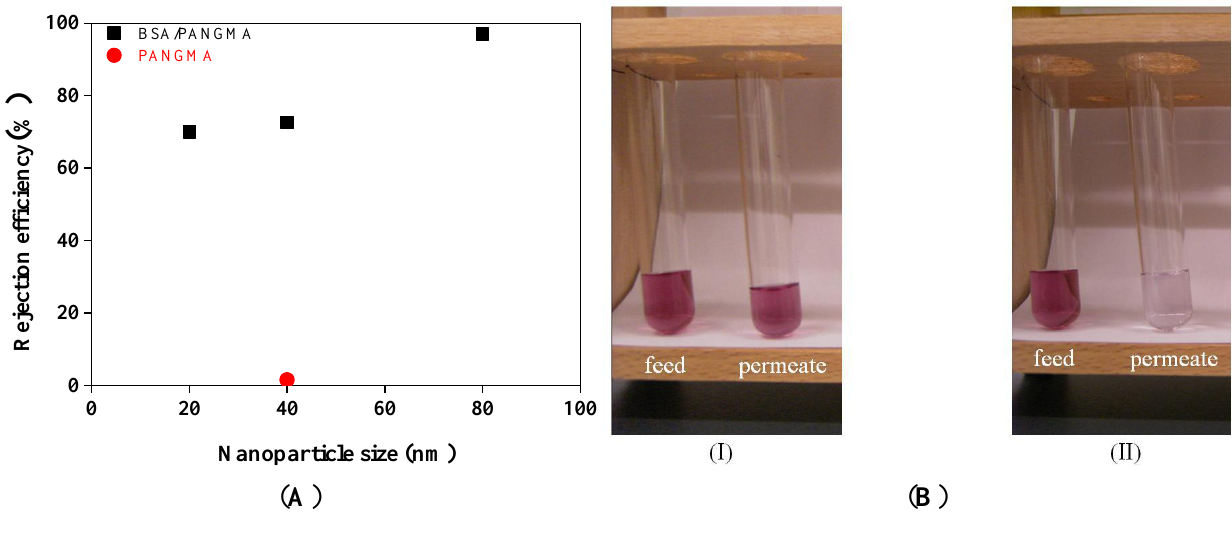
Figure 10. ( A ) Extraordinary retention efficiency of the BSA/PANGMA ENMs for Au nanoparticles and ( B ) visual comparisons between the feed and permeated samples through the neat (I) and BSA/PANGMA ENMs